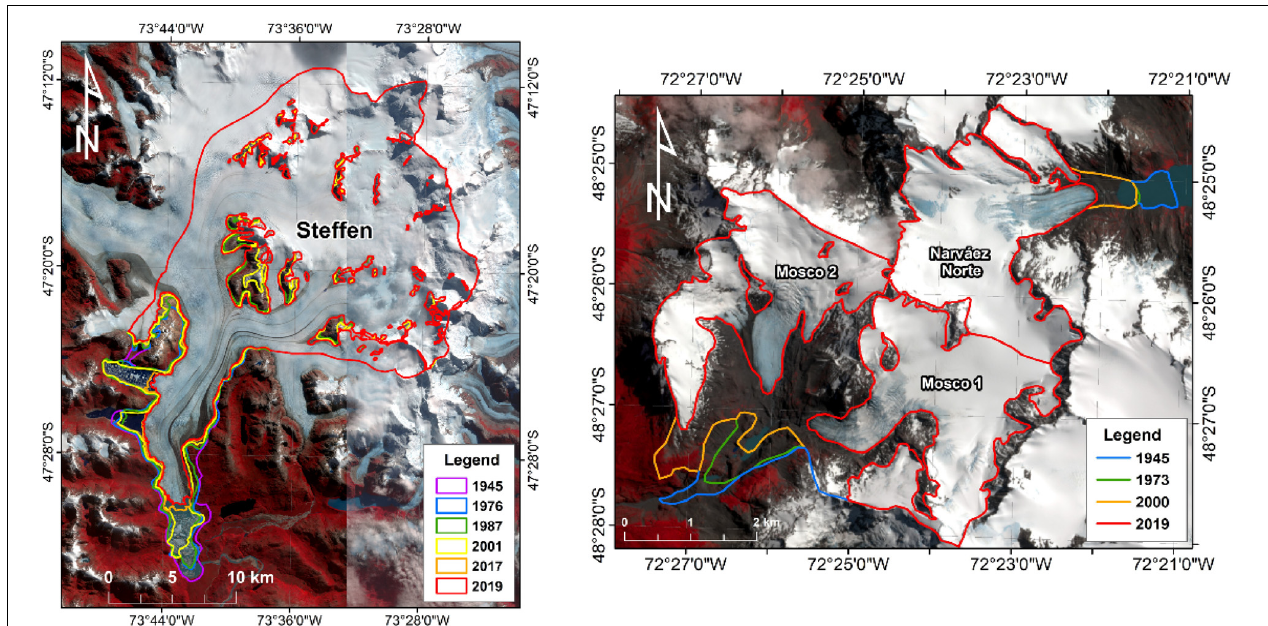
FIGURE 7 | Areal recession of south Patagonian glaciers between 1945 and 2019. Sources: Available aerial photographs and satellite